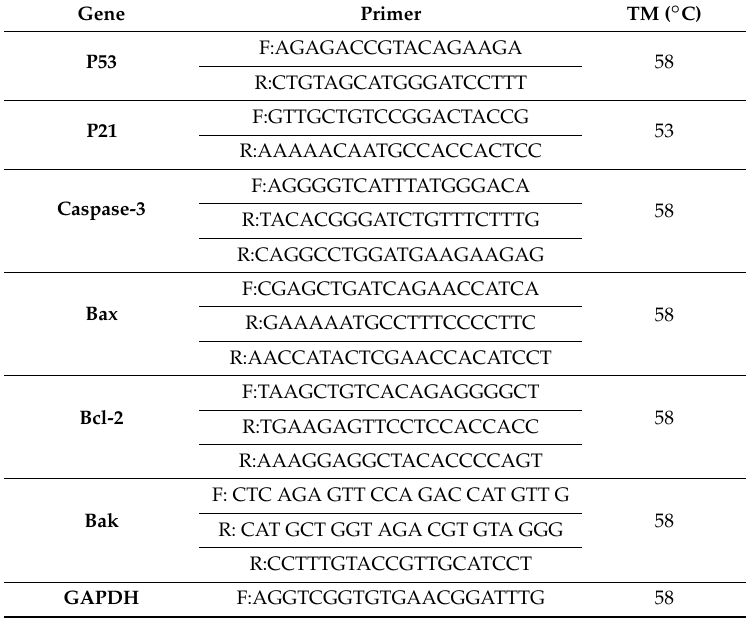
Table 2. List of primers used for quantitative real-time polymerase chain reaction for analysis of apoptotic gene